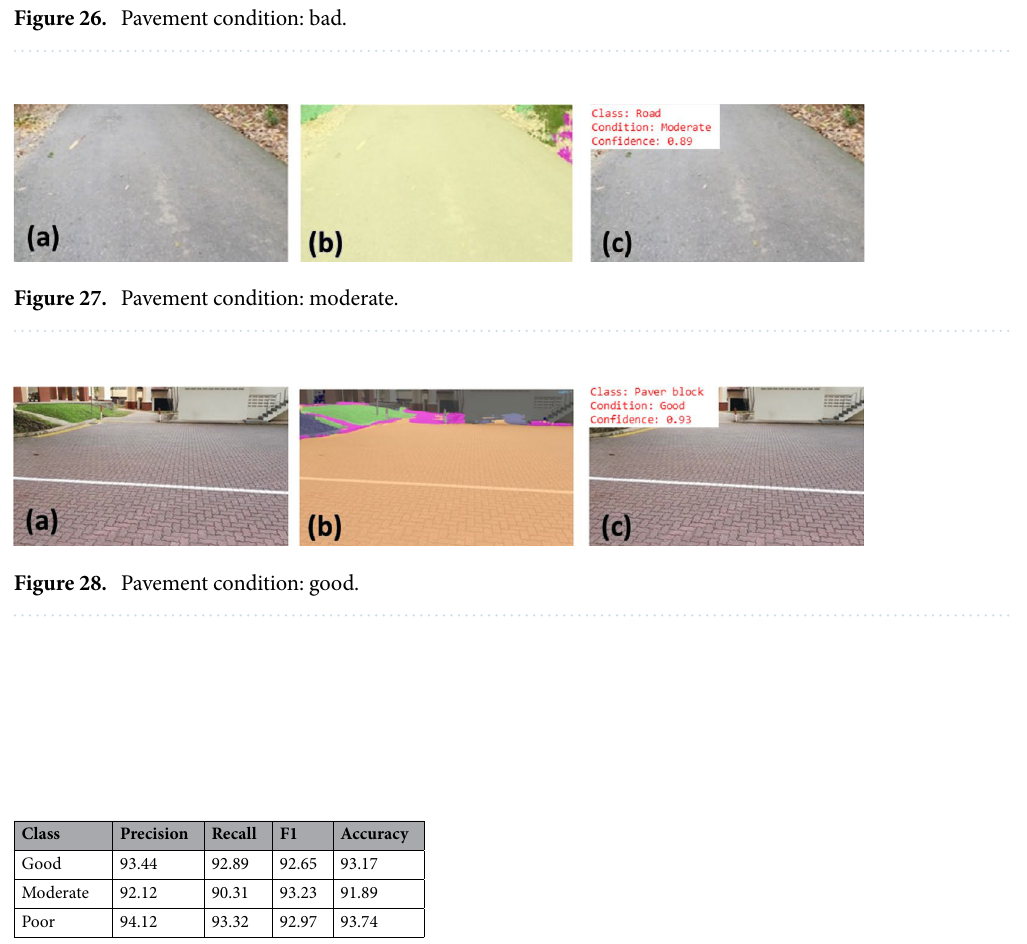
Table 5. Statistical measures analysis for pavement’s surface